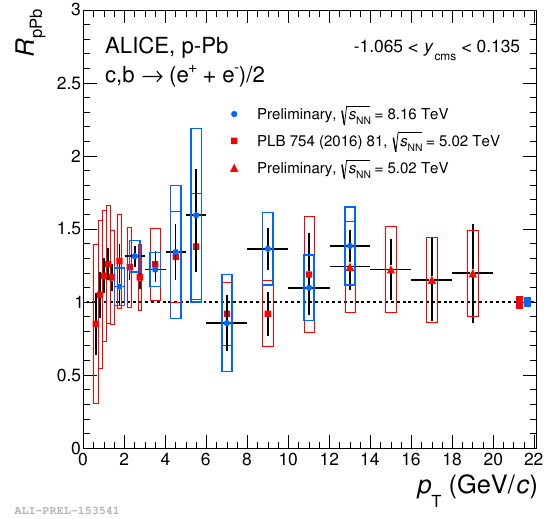
Figure 4. The nuclear modification factors of electrons from heavy-flavour hadron decays in p–Pb √ √ s NN = 8.16 TeV and s NN = 5.02 collisions at